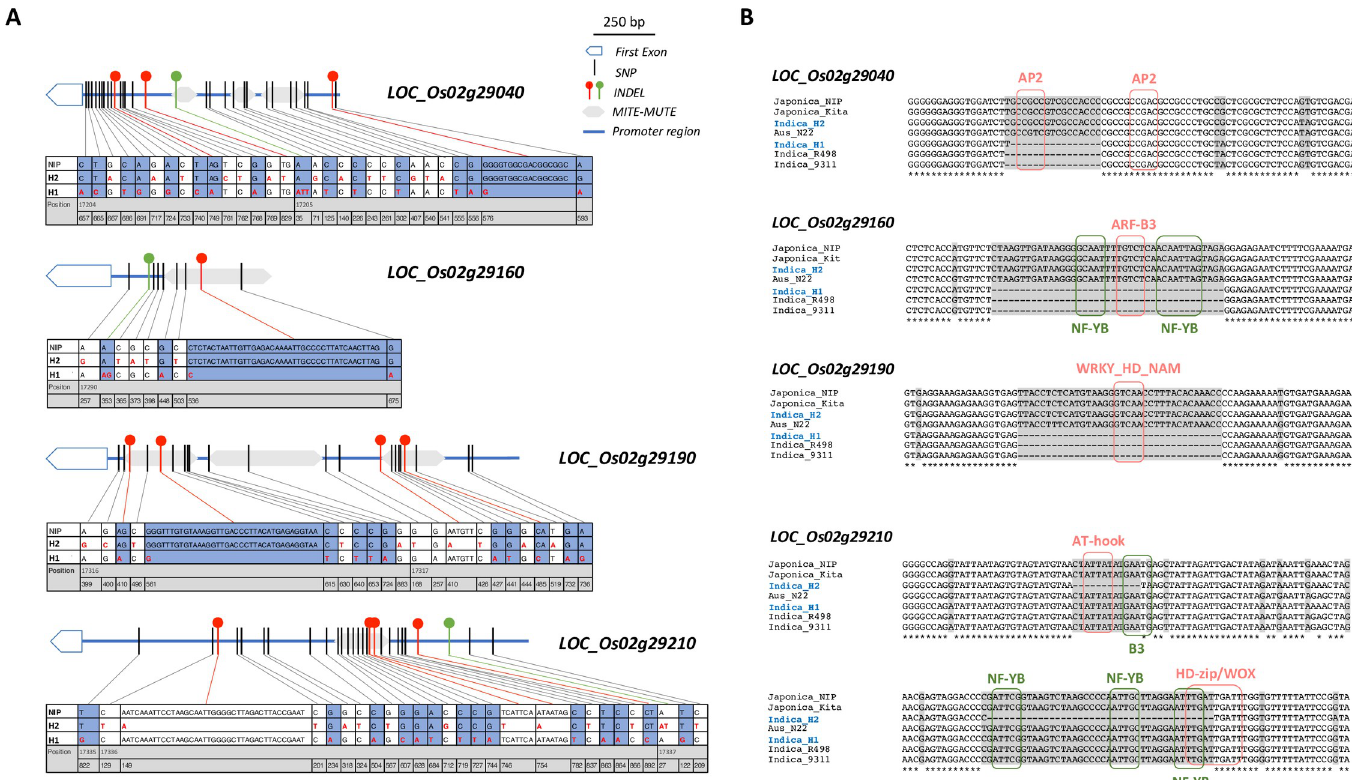
Fig 4. Promoter regions of the ANK and ANK-TPR genes with differential expression between the two haplotypes. (A) Promoter regions and the first exon of the 4 ANK and ANK-TPR genes showing differential expression between the haplotypes H1 and H2. INDELs are indicated by dotted lines: red with a deletion in H1 and green with a deletion in H2 compared to the O . sativa ssp . japonica cv. Nipponbare MSU7.0 reference genome. The sequences and positions of polymorphic sites for the cultivar Nipponbare (Nip) and the H1 and H2 haplotypes (H1, H2) are indicated below, with the H1 vs. Nip polymorphic sites in blue and the H2 vs. Nip polymorphic sites in white. (B) Sequence alignment of the promoter regions showing large deletions in the two haplotypes (Indica_H1, Indica_H2) for the ANK and ANK-TPR genes from the two O . sativa ssp . japonica Nipponbare (Japonica_Nip) and Kitaake (Japonica_Kita) genomes; the two O . sativa ssp . indica R498 and 93–11 genomes (Indica_R498, Indica_9311 respectively); and the O . sativa aus N22 genome (Aus_N22). The positions of the putative TFBSs are indicated by red and green boxes, as well as the names of the corresponding